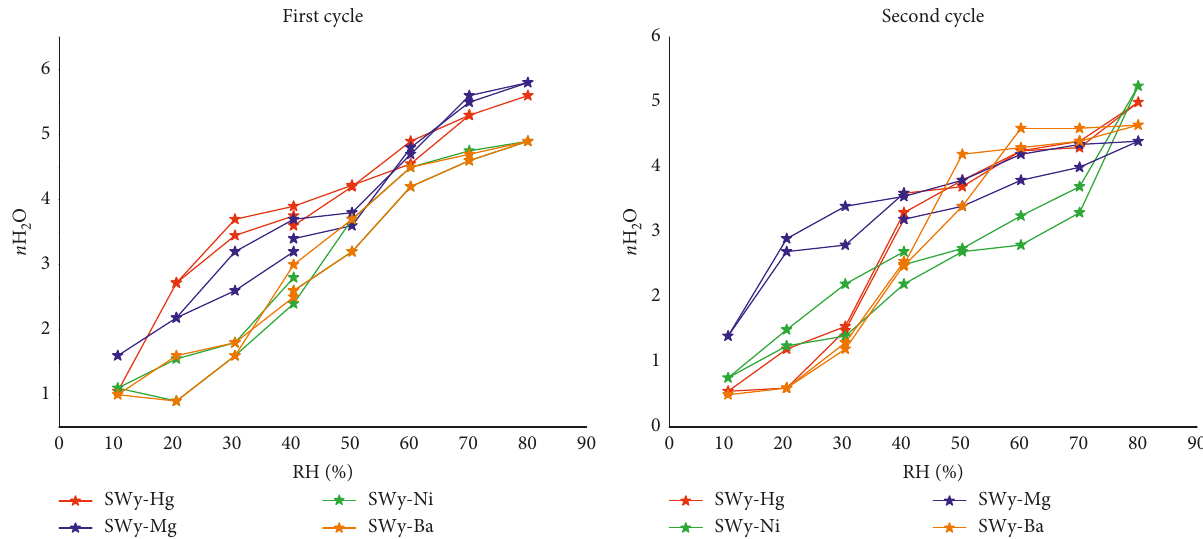
Figure 8: Comparison between the evolutions of the interlamellar water amount of the montmorillonite exchanged with different bivalent cations during the